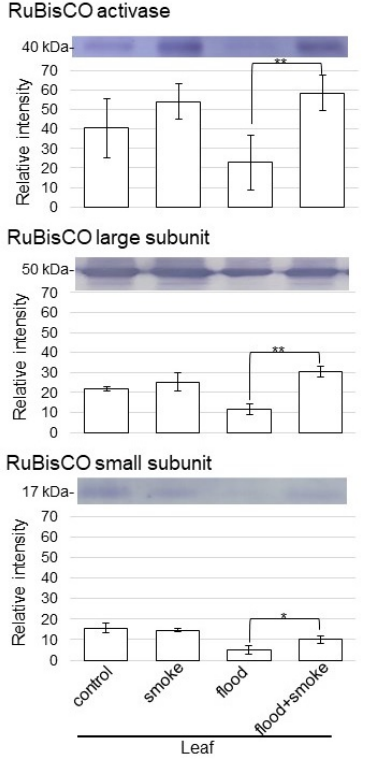
Figure 5. Immunoblot analysis of the proteins involved in photosynthesis in wheat treated with the plant-derived smoke solution under flooding stress. Proteins extracted from leaves of wheat seedlings were separated on SDS-polyacrylamide gel by electrophoresis and transferred onto mem- branes. The membranes were cross-reacted with anti-RuBisCO activase, the RuBisCO large subunit, and the RuBisCO small subunit antibodies. A staining pattern with Coomassie-brilliant blue was used as a loading control (Figure S1). The integrated densities of the bands were calculated using ImageJ software. The data are presented as mean ± SD from 3 independent biological replicates (Figure S2). Asterisks indicate significant changes in the relative intensity of signal band in the plant-derived smoke solution under flooding compared to only flooding according to the Student’s t -test (**, p < 0.01; *, p < 0.05).